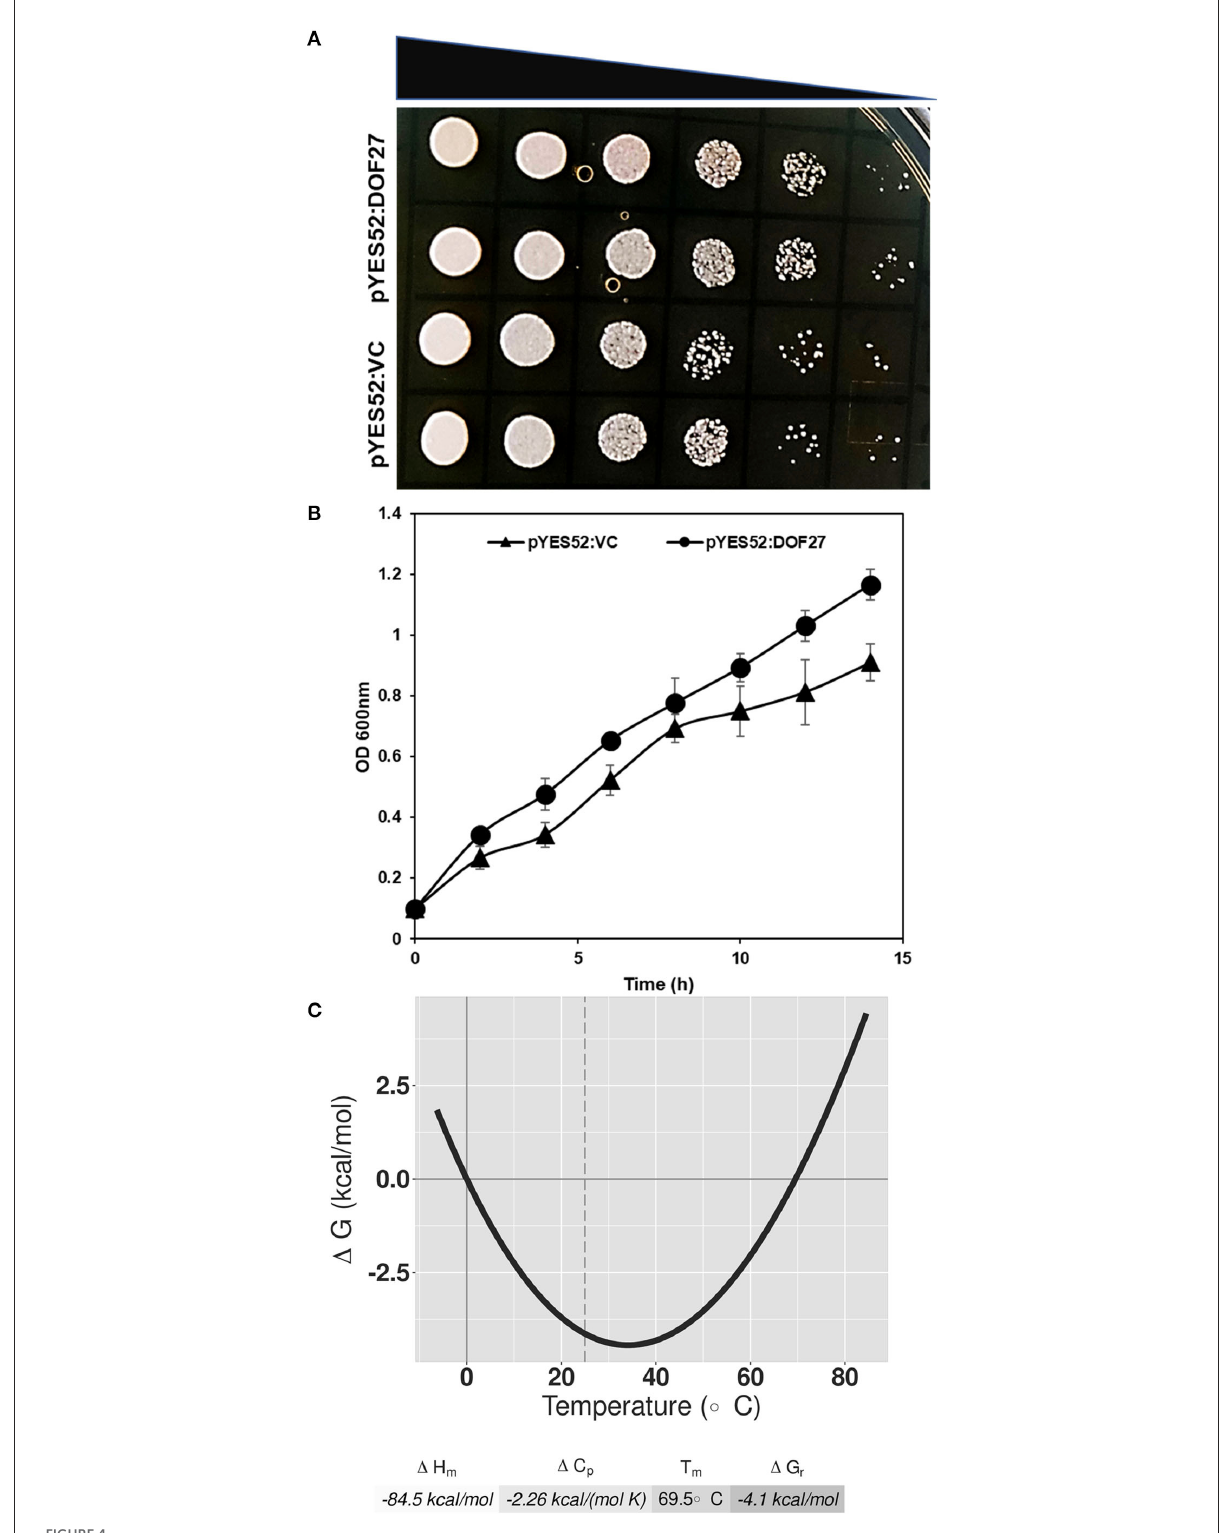
FIGURE4 Thermotolerance potential of yeast is shown by (A) Spot assay which represents the comparative growth of yeast cells harboring pDEST52: OsDOF27 and empty vector. Five microliters of each yeast sample (two colonies) were used for spot assay with 10-fold serial dilutions. (B) the curve depicts the growth of yeast cells harboring pDEST52: OsDOF27 and empty vector under thermal stress. (C) The thermal stability curve represents the standard free energy of protein folding against the